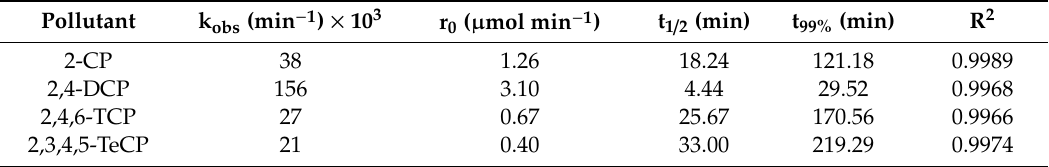
First–order rate constant (k ob ), initial rate of photocatalytic degradation (r 0 ), correlation coe ffi cients and illumination times during which 50% (t 1 / 2 ) or 99% (t 99% ) of pollutant are